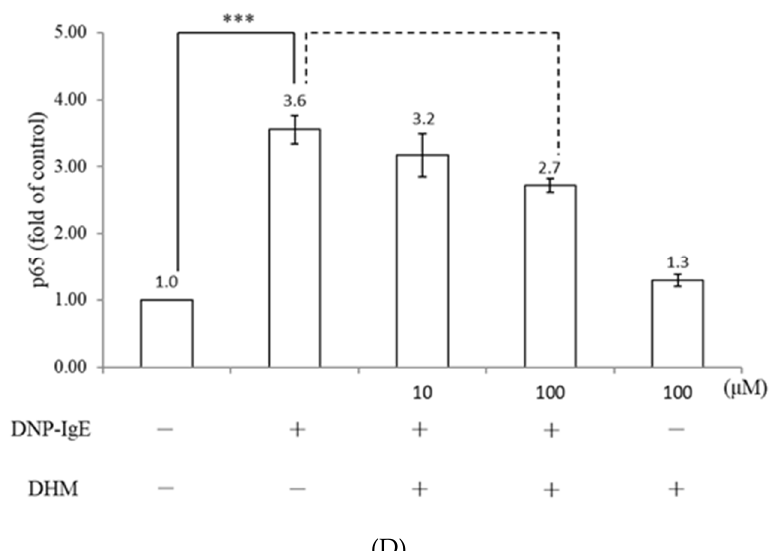
Figure 3. The effect of DHM on cytokine production and signaling pathway. Incubation with DHM led to decreased production of TNF- α ( A ) and IL-6 ( B ) after sensitization with DNP-IgE. All bars depict the mean of 3 repeated experiments with SD. ** p < 0.01, *** p < 0.001 as compared with the untreated control and # p < 0.05, ## p <0.01, ### p < 0.001 as compared with DNP-IgE. Levels of total and phosphorylated MAPKs ( C ) and the expression of NF- κ B ( D ) were assessed by western blot.